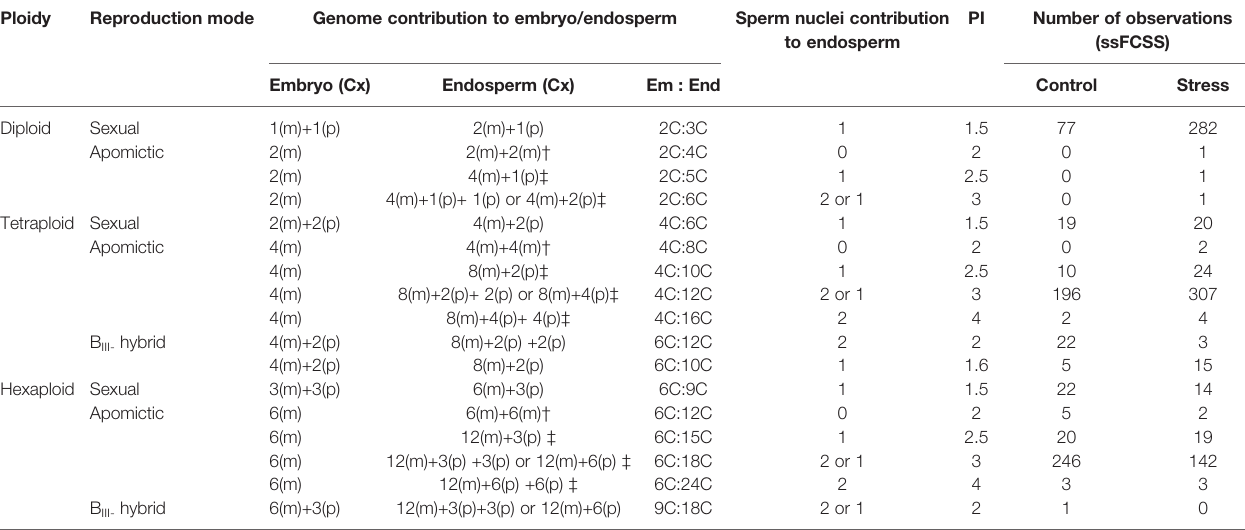
TABLE 2 | Observed reproductive pathways of three cytotypes of the R. auricomus complex.